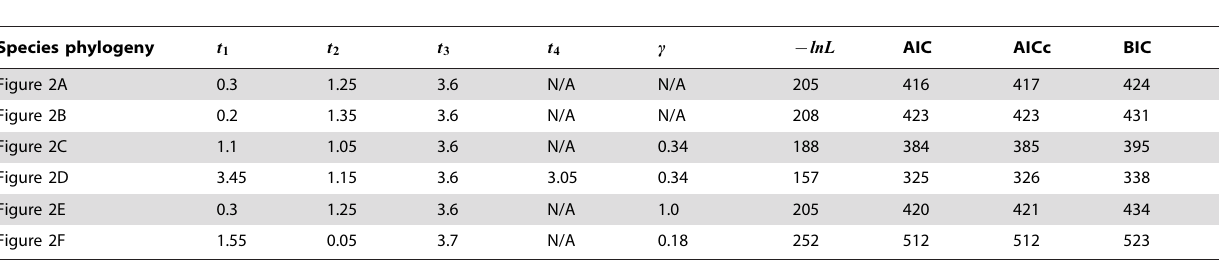
Table 2. Analysis results for the six phylogenies in Figure 2 using gene tree topologies inferred by maximum parsimony (using PAUP*).